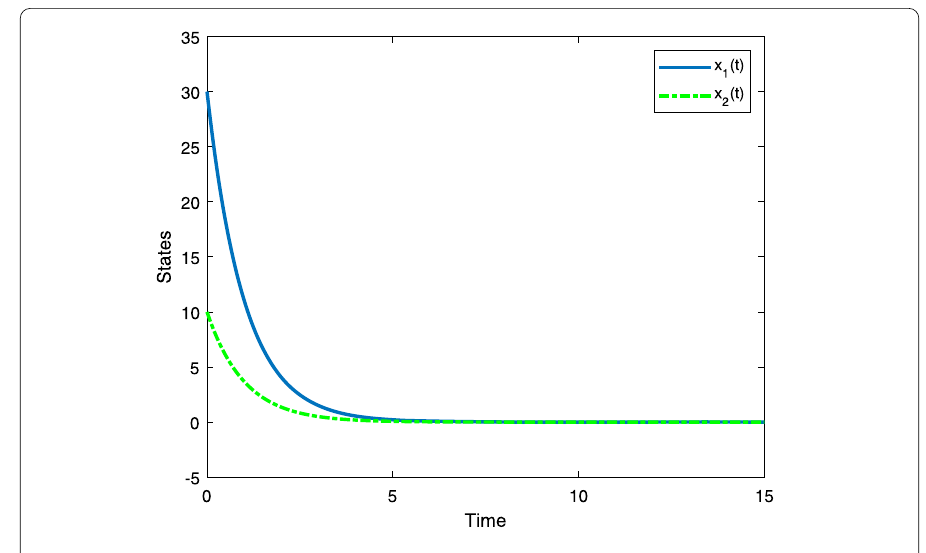
Figure 3 State response of the closed-loop system with τ a = 0.3